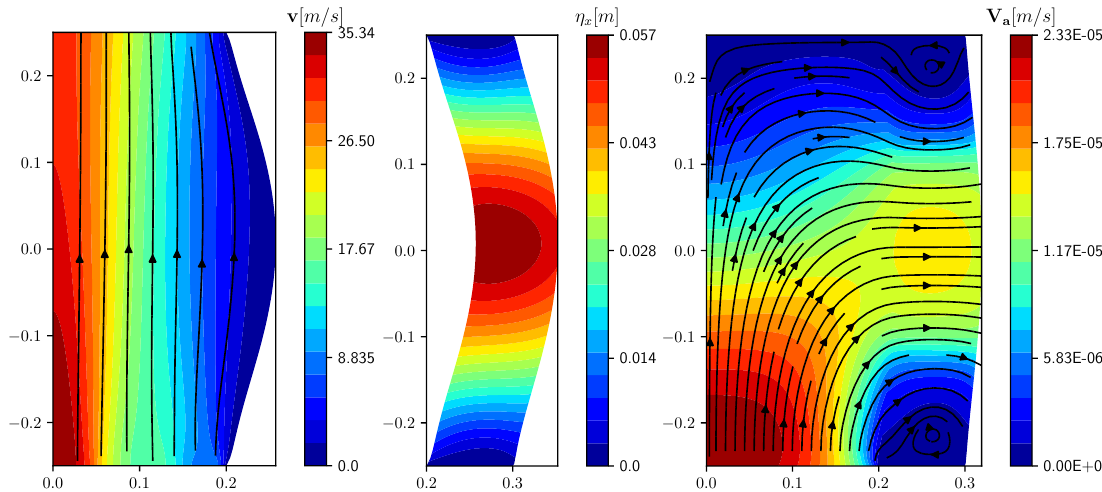
Figure 2. Control pressure profile with α = 10 − 8 (A), α = 10 − 9 (B) and α = 10 − 10 (C).